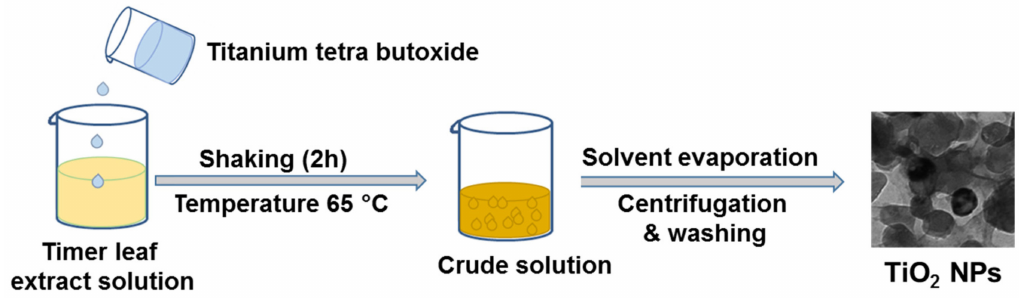
Figure 1. Biosynthesis of TiO 2 NPs. Here, leaf extract of Z. armatum and butanol were applied as reducing agent and templating agent,